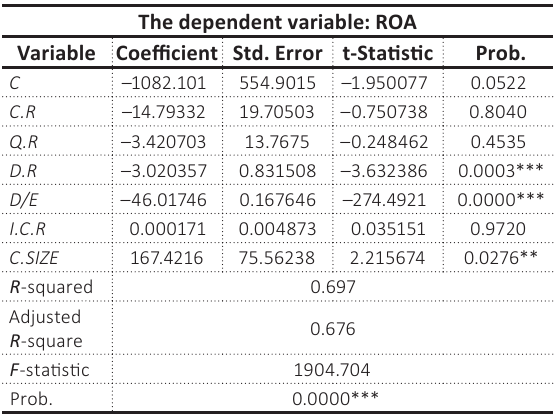
Table 6. Results of H02-1–H02-3 testing The dependent variable: ROA Variable Coefficient Std. Error t-Statistic